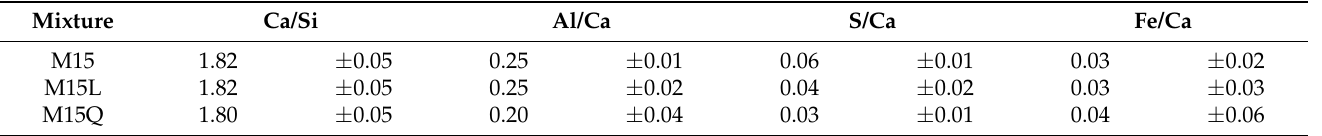
Table 5. C-A-S-H composition for mixtures M15, M15L and M15Q after 91 days of standard